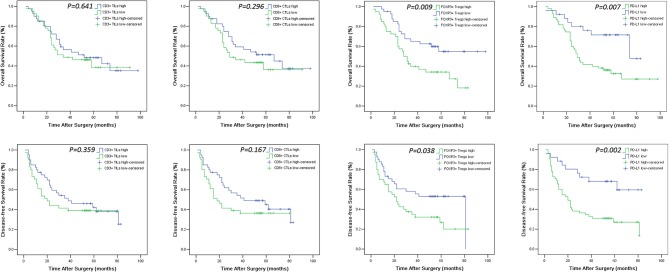
OS and DFS survival Kaplan-Meier curves of CD3+ TILs, CD8+ CTLs, FOXP3+ Tregs count and PD-L1 expression level in the tumor. Log-rank test was used to compare the above curves.